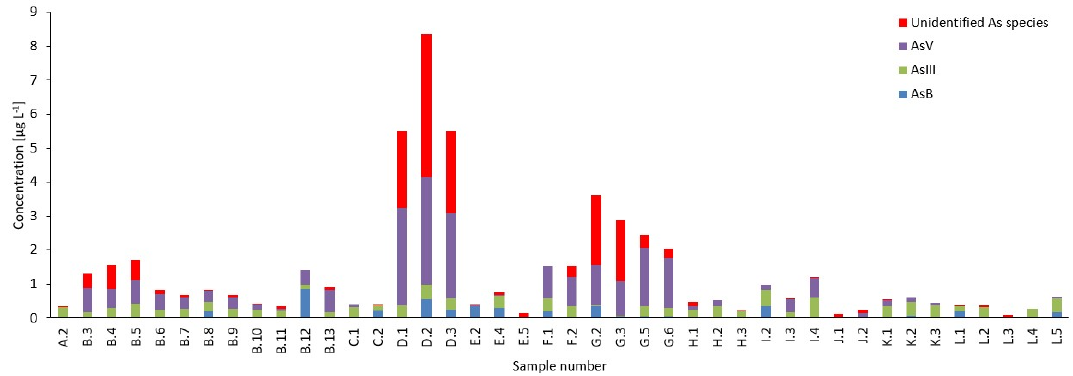
Figure 1. Mass balance for total arsenic (bar height represents total arsenic concentration) and arsenic species in flavored and functional bottled drinking water samples. Unidentified As refers to the difference between total As and sum of As species. Letters in the sample codes denote the same sample brand.